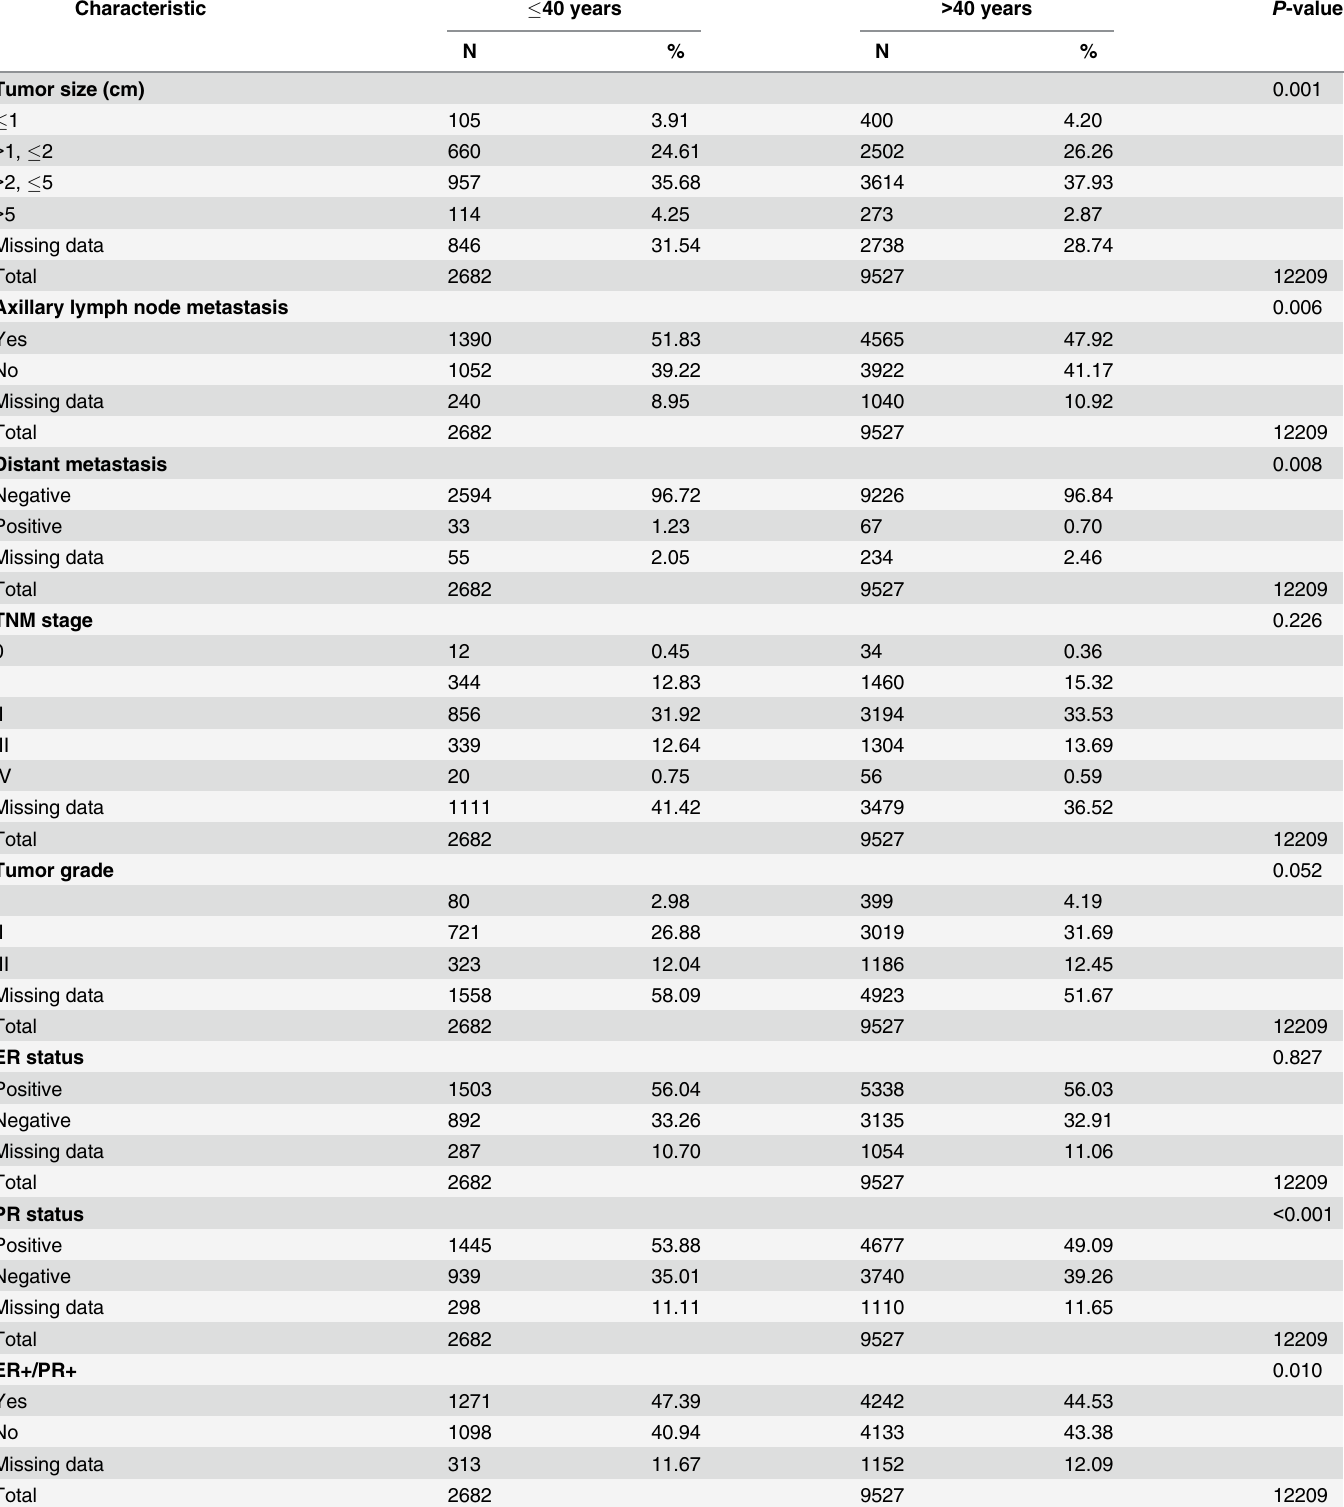
Table 2. Comparison of clinicopathological features and biomarker expression levels (immunohistochemical detection) between young ( (cid:1) 40 years) and older ( > 40 years) female breast cancer patients.